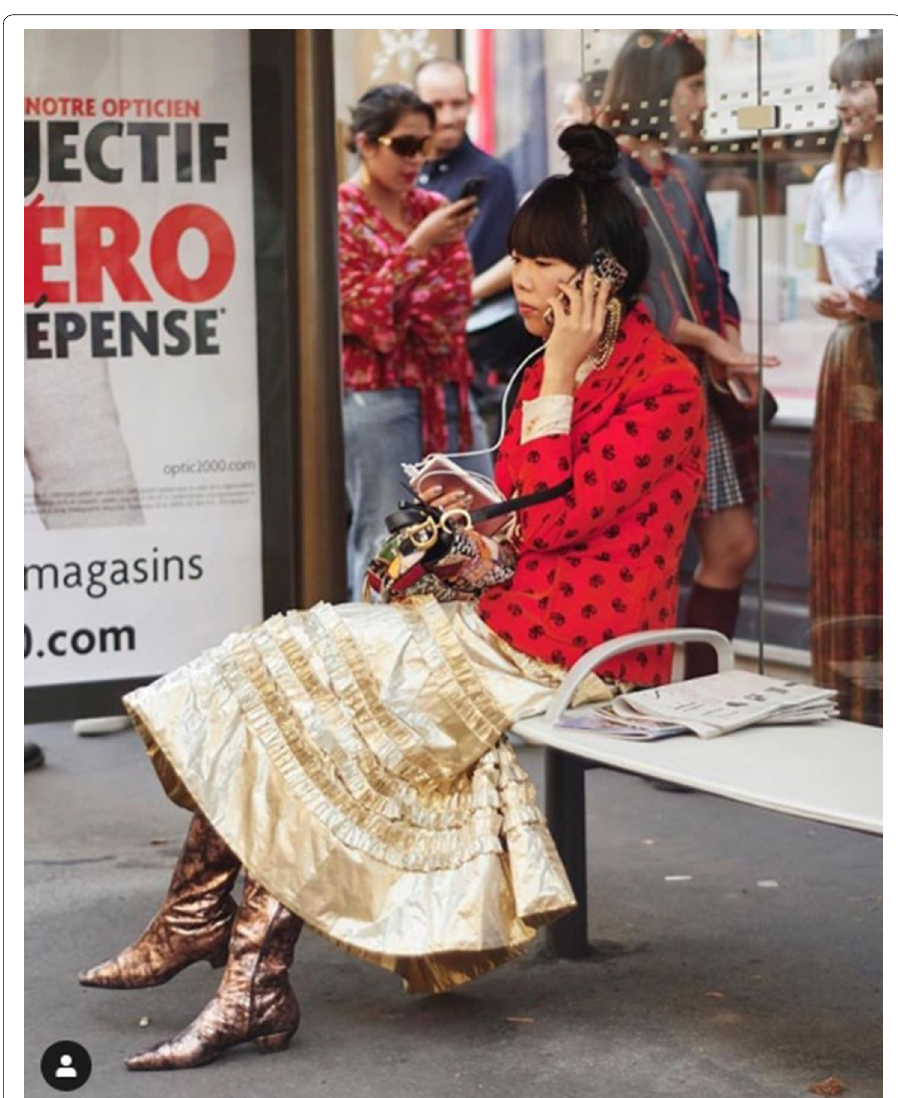
Fig. 4 Working out of le bus stop. https ://www.insta gram.com/p/Bs2my MTh1-0/. Accessed 5